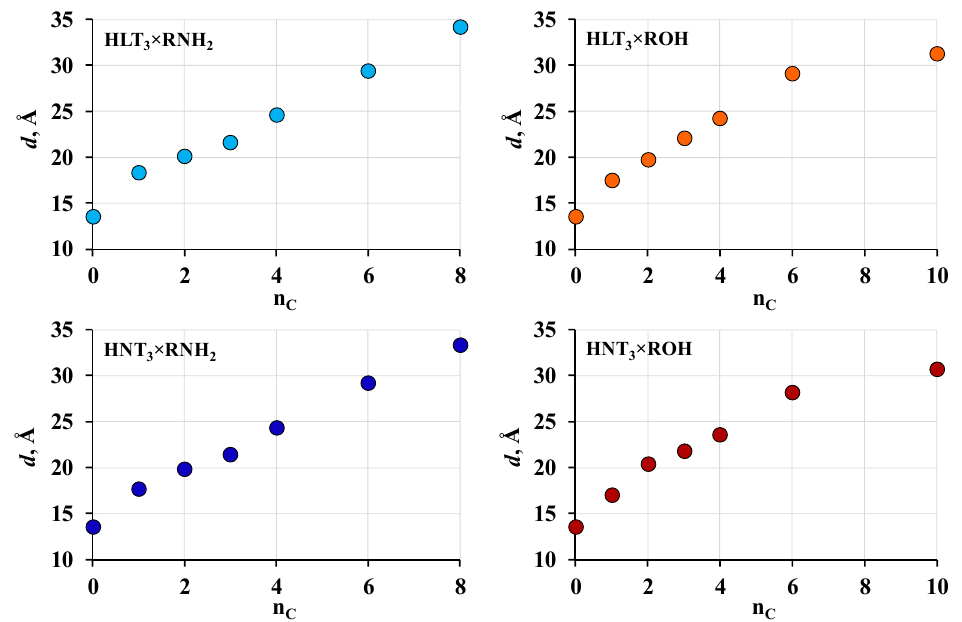
Figure 2. Dependences of the interlayer distance d on the organic chain length.